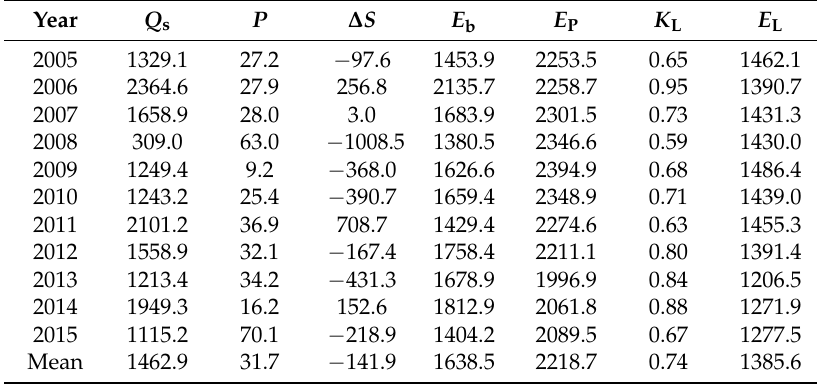
Figure 8. The yearly change of lake evaporation ( E L , mm) calculated by the water budget method (Wb) without considering the ground runoff and by the modified PenPan model (Cal) and observed E L (Obs, 2014 and 2015) and surface runoff ( Q s , mm). The mean of E L (straight line) calculated by the modified PenPan model is also shown. Table 3. The yearly water budget of Lake Juyan with full water area from 2005 to 2015. The surface runoff ( Q s , mm), precipitation ( P , mm), change of storage ( Δ S , mm), and estimated lake evaporation by water budget ( E b , mm, equal to Q s + P − Δ S ), pan evaporation ( E p , mm), coefficient ( K L ) of E b to E p , and calculated lake evaporation ( E L , mm) by the variable K p are shown.